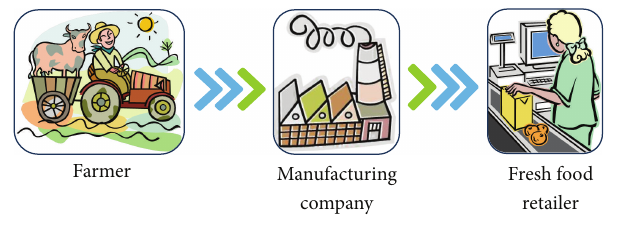
Figure 1: The fresh food supply